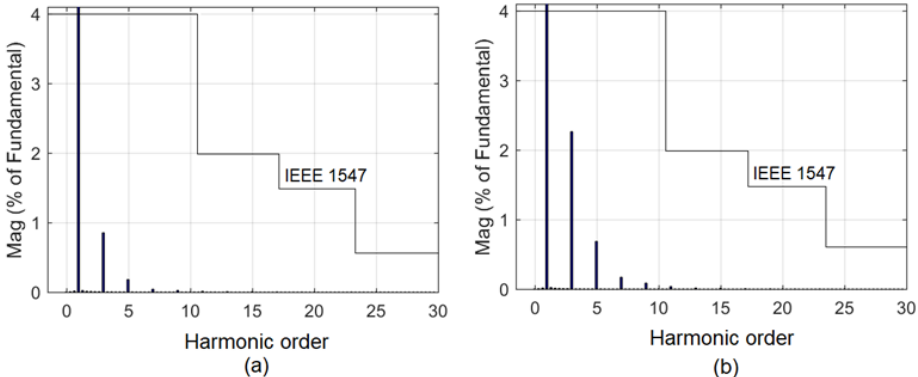
Figure 7. Harmonic spectra and the limits of IEEE 1547 Standard for the grid currents with invariant control at 100% load with uncertainty in the grid inductance; ( a ) with L min , and ( b ) with L max . Table 5. Comparing THD using the suggested controller and the H ∞ controller at L gmin and L gmax . Invariant Sets Controller